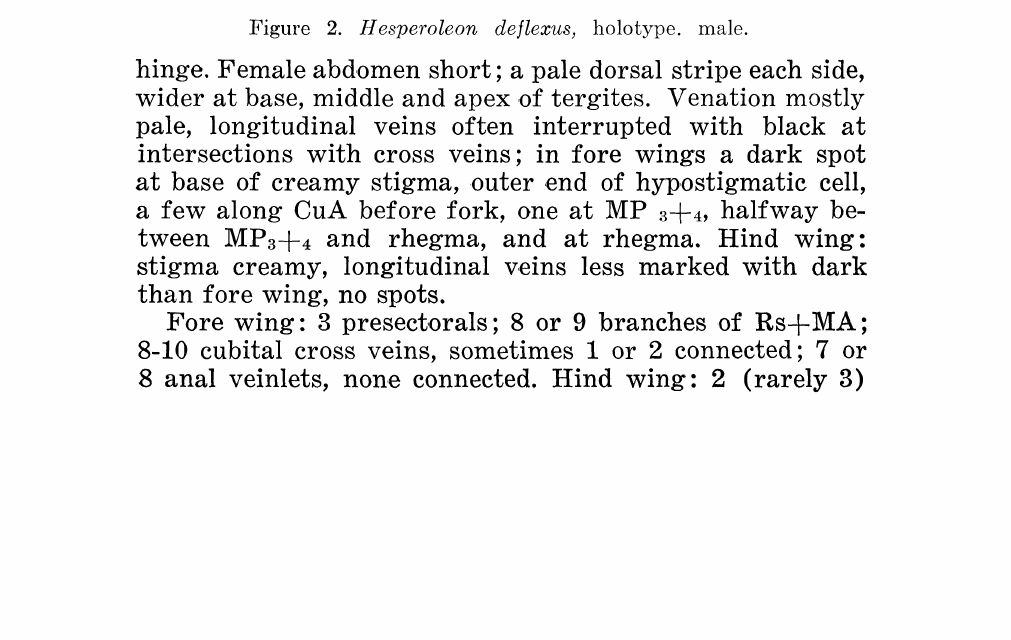
Figure 2. Hesperoleon de/lexus, holotype,